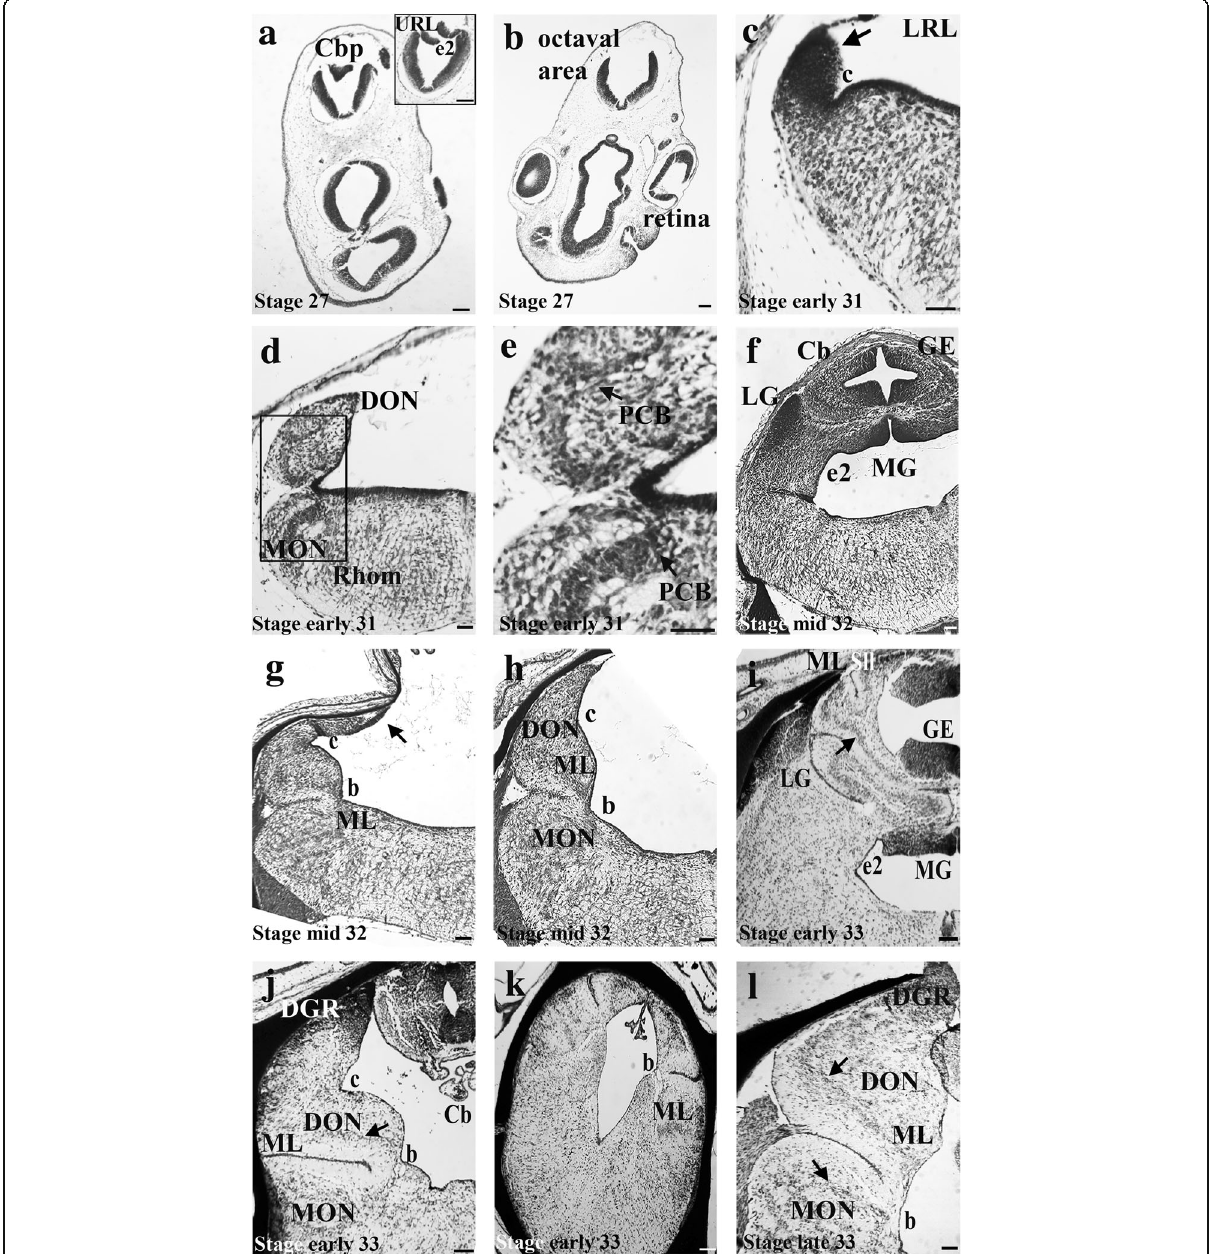
Fig. 4 Light micrographs of Leucoraja erinacea sections showing cerebellar and cerebellar-like development. Stage 27 embryonic brain showing the incipient Cbp ( a ) and octaval area ( b ). Inset is a section between a and b, showing the URL and e2 sulcus. Early stage 31 brain showing the LRL and the incipient LG ( c , arrow) with PCB ’ s in the DON (AENs) and MON (cell plate X) ( d ). Principal cell bands can be seen in inset from d, showing a higher magnification image of the PCB ’ s ( e ). Mid-stage 32 brain showing the incipient LG, MG, GE and cerebellar body ( f ), the DGR-like “ sliver ” of cells ( g , arrow) and the newly formed DON and MON ML ’ s ( h ). Early stage 33 brain showing the cerebellar ML as well as LG, MG, GE and the Sll. Arrow points to Purkinje cell layer ( i ). Early stage 33 brain showing the newly formed DGR. Arrow points to PCB ( j ). Caudal section of the early stage 33 brain showing the ML extending past the obex ( k ). Late stage 33 brain showing the fully formed DGR, DON and MON MLs (arrows point to PCB) ( l ). Scale bars equal 100 μ m. Abbreviations: b , sulcus b; c , sulcus c; Cb , cerebellum; Cbp , cerebellar plate; DON , dorsal nucleus; e2, sulcus e2; GE , granular eminences; LG , lateral granule cell mass; LRL , lower rhombic lip; MG , medial granule cell mass; ML , molecular layer; MON , medial nucleus; PCB , principal cell band; Rhom , rhombencephalon; Sll , sulcus longitudinalis lateralis; URL , upper rhomic